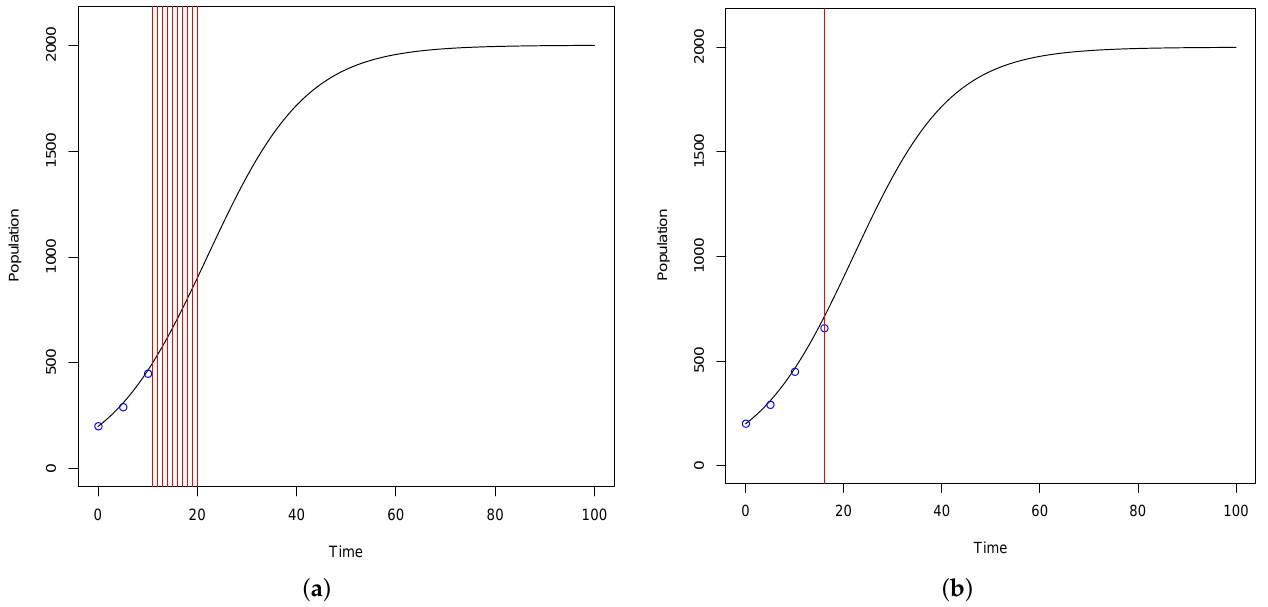
Figure 2. A window of ten candidate points are selected from the last point sampled illustrated by the red region in panel ( a ). Each point is evaluated using A optimality criterion and the argument with the minimum trace in the window is selected as shown in panel ( b